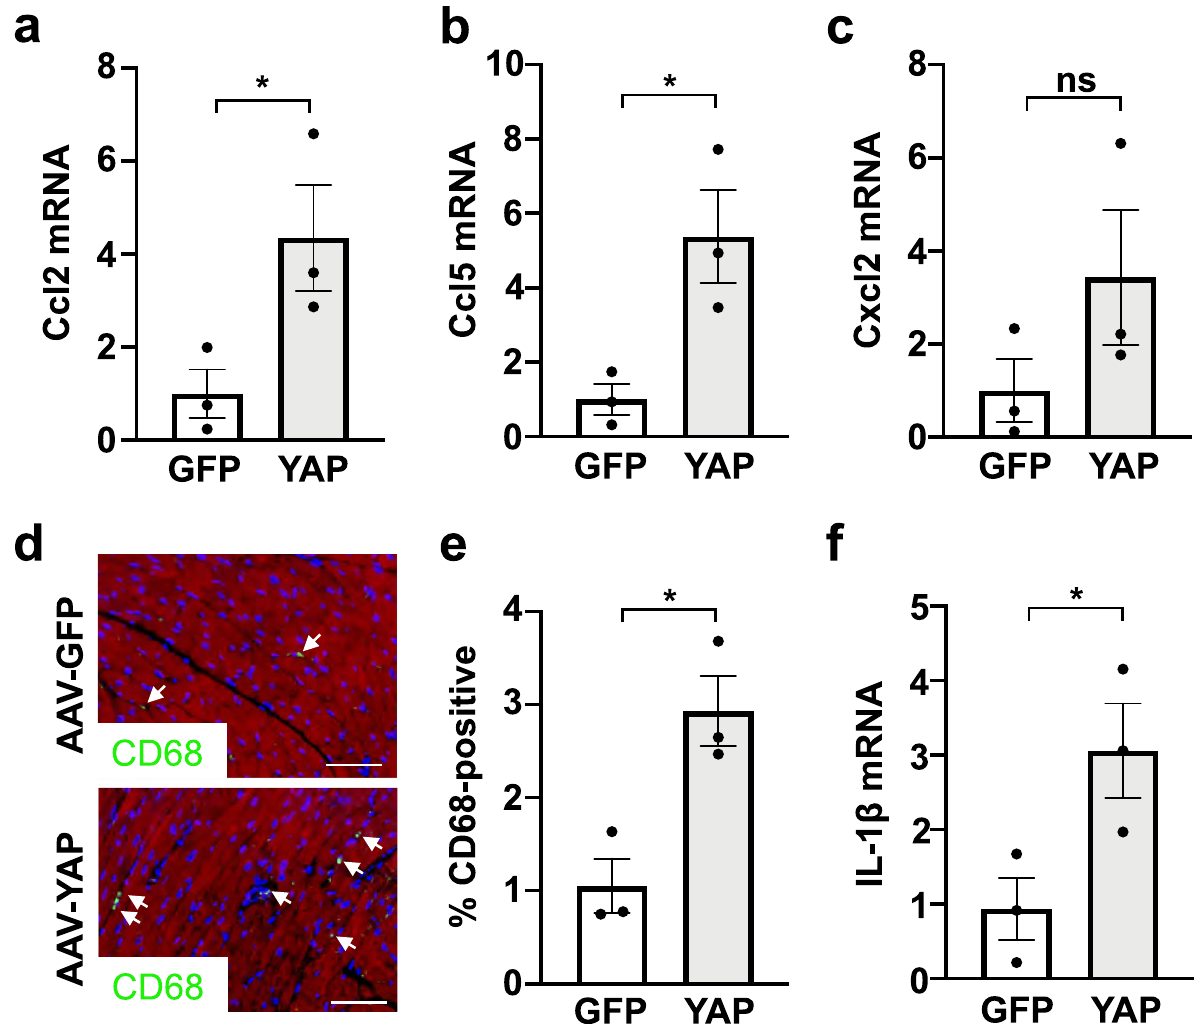
Figure 6. Transduction with AAV-hTCF21-FLAG-YAP upregulates inflammatory markers in the heart. Wild type C57BL/6J mice were administered AAV-hTCF21-GFP or AAV-hTCF21-FLAG-YAP. ( a–c ) RNA was isolated from LV tissue for qPCR analysis. ( d , e ) Hearts were sectioned for immunostaining to detect CD68 + macrophages (green), cardiac troponin T (red), and nuclei (DAPI). White arrows identify CD68- positive cells. Quantification of CD68-positive cells in panel ( e ). Scale bar, 100 μm. ( f ) IL-1b mRNA was measured in LV tissue by qPCR. N = 3 mice/group. *p < 0.05. ns not